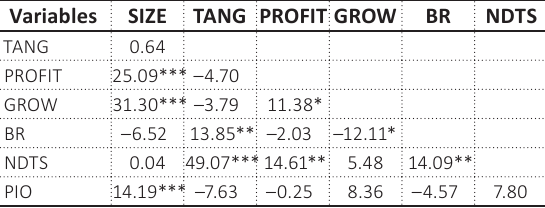
Table 2. LLC test results